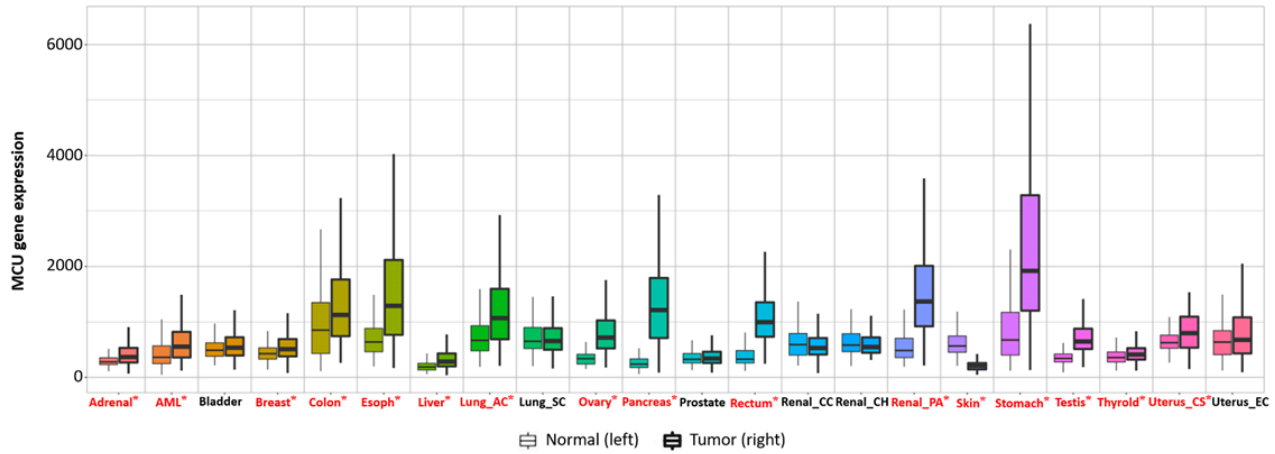
Figure 5. Transcriptional expression level of the MCU in various normal and cancerous organs. The MCU is closely related to multiple cancers; the expression levels of the MCU in most tumors are not consistent with those in normal tissues. The majority of tumors have significantly elevated levels of MCU expression. Significant differences by Mann−Whitney U test are marked with red and *. MCU, mitochondrial calcium uniporter.